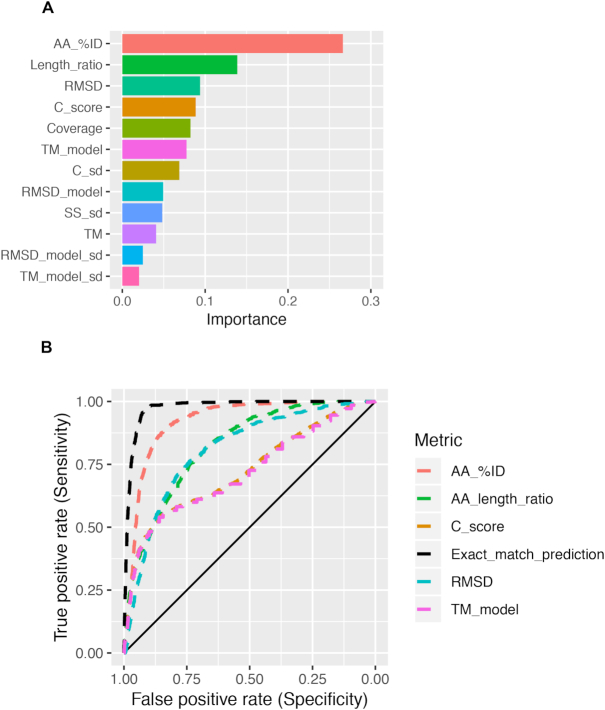
A random forest classifier correctly identifies the majority of high-confidence models using I-TASSER software output and derived metrics. (A) Relative importance of 12 metrics used to predict the presence of matching Pfam terms between query peptides and reference peptides identified via structural homology searching. (B) Receiver operating characteristic curves for the best-performing individual metrics (AUC ≥0.7; Table 1) and the random forest classifier (“Exact_match_prediction”). The unbroken x = y line represents chance prediction.